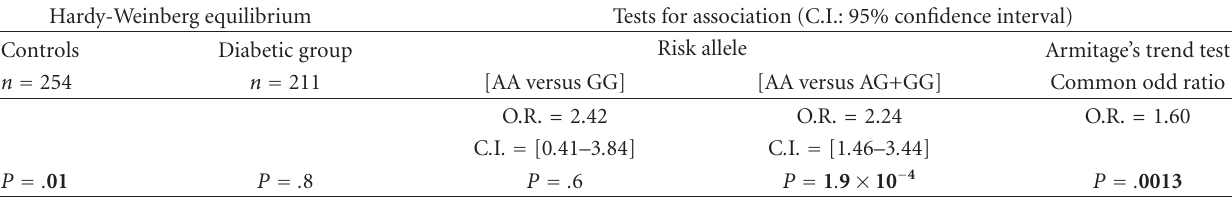
Table 3: Hardy-Weinberg equilibrium and association tests for A-2819G SNP. Hardy-Weinberg